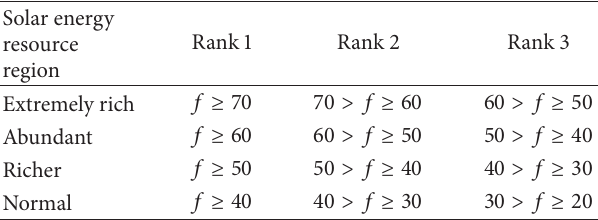
Table 6: Rank of the solar energy fraction for a solar space heating system in different solar energy resource regions.